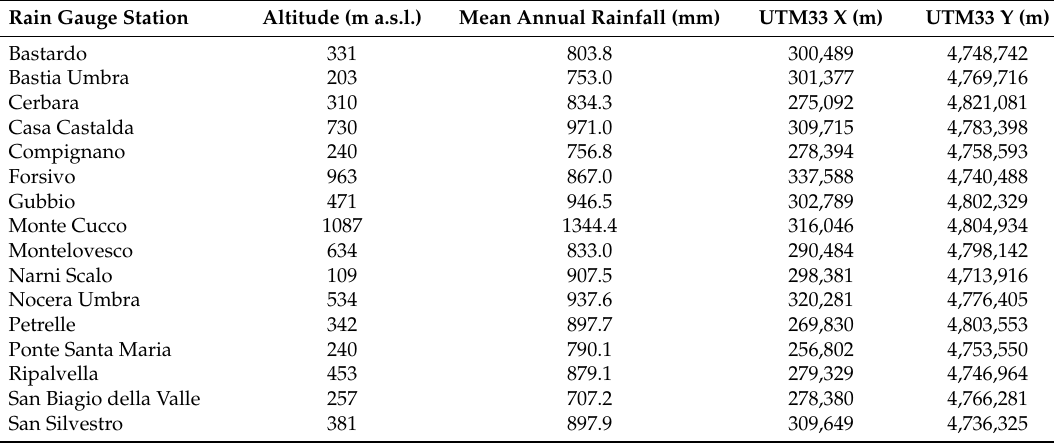
Figure 1. Morphology and the rain gauge network of the Umbria region. The position of the rain gauges used in the analysis is also shown. Table 1. Main characteristics of the selected rainfall stations located in the Umbria region (central Italy). The geographic location is in Universal Transvers Mercator (UTM) coordinates computing by using the WGS84 ellipsoid